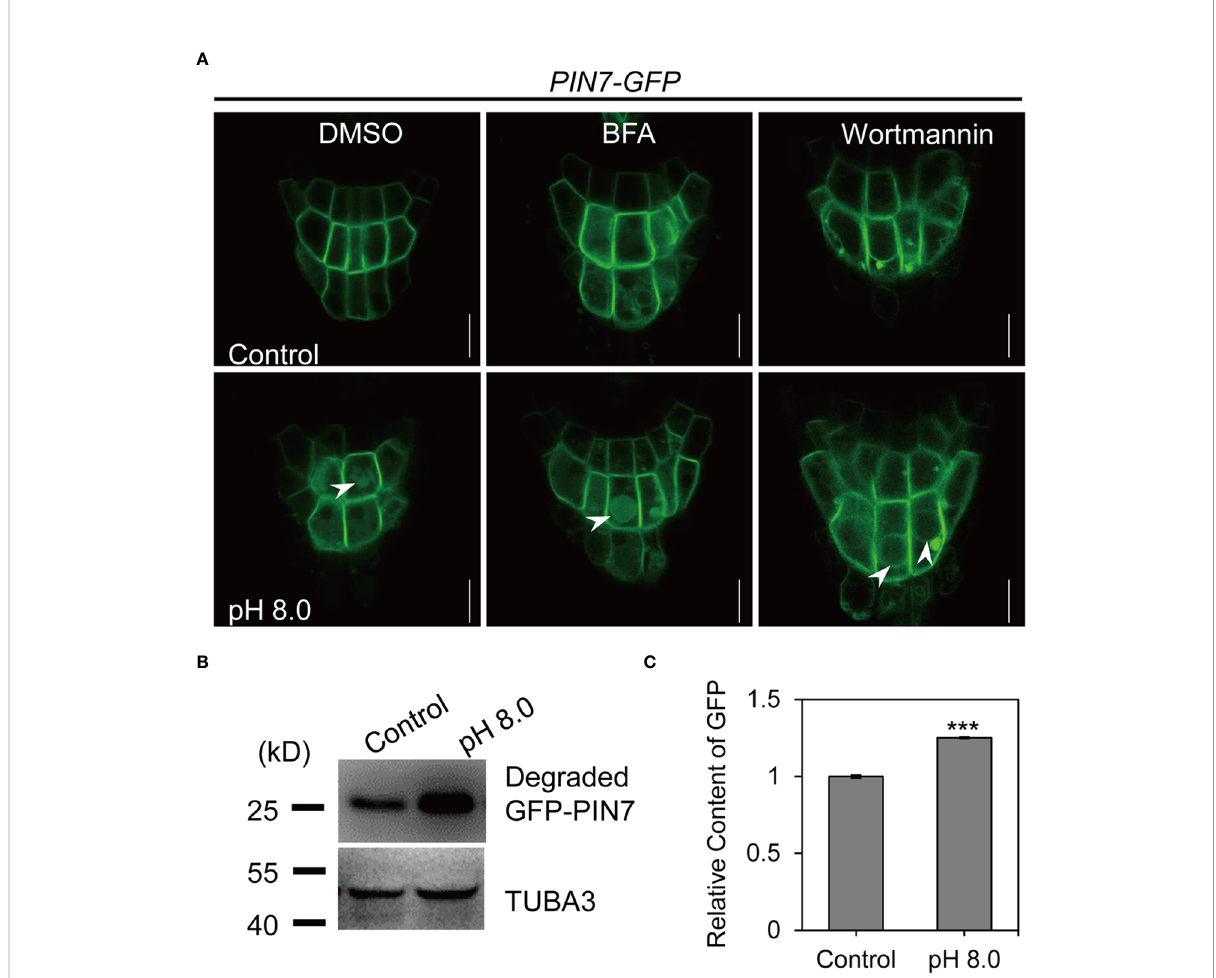
FIGURE 5 PIN7 protein is transported to vacuole lumen through vacuolar sorting pathways under alkaline stress. (A) BFA treatment does not interfere with the vacuole lumen localization of PIN7 under alkaline conditions while wortmannin treatment abolishes this process. PIN7 – GFP transgenic plants were grown on 1/2 MS medium at pH 5.8 for 5d and were then transferred to medium at pH 5.8 (control) or pH 8.0 with BFA (50 mM) or wortmannin (33 mM) or DMSO overnight, before imaged by confocal microscope. Scale bar, 10 mm. (B, C) Western blot and grayscale analysis of the released free GFP from PIN7 – GFP fusion protein under control (pH 5.8) or alkaline (pH 8.0) conditions. Statistically signi fi cant differences were determined by using student ’ s t-test (*** P <